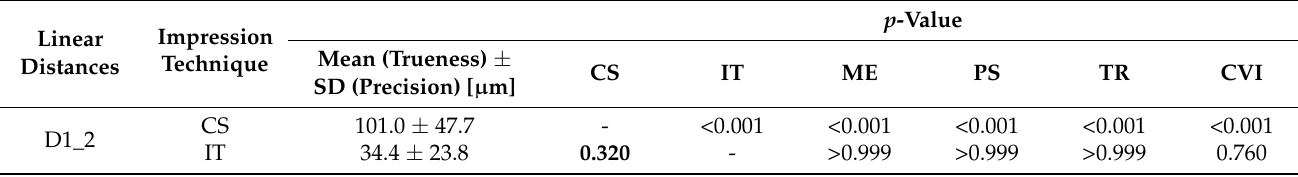
Table A3. Deviations (mean ± standard deviation (SD) [ µ m]) of the linear distances (D1_2, D1_3, D1_4, D2_3, D2_4, D3_4) of six impression techniques (CS = CS 3800, IT = iTero Element 5D, ME = Medit i700, PS = Primescan, TR = Trios 4, CVI = conventional impression) for Group C (young fully dentate) and statistical analysis for trueness (upper right part) and precision (lower left part, presented in bold type) according to ISO 5725